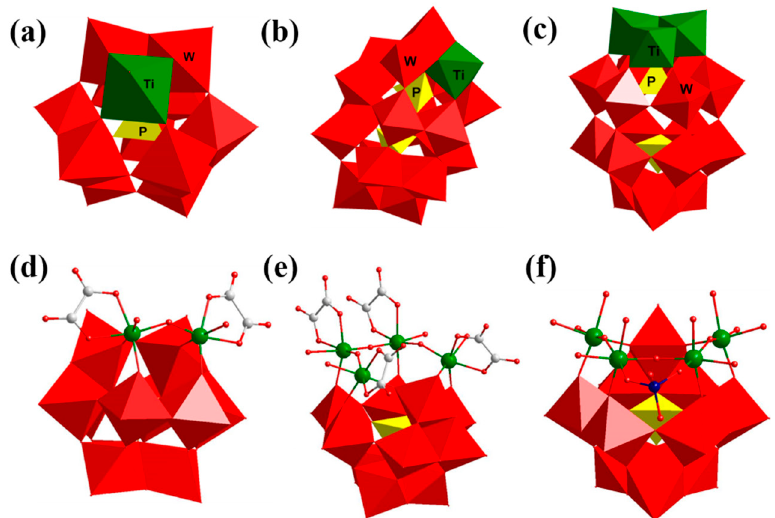
Figure 1. The ball-and-stick and polyhedral illustration of ( a ) [TiW 11 PO 40 ] 5 − polyoxoanion, ( b ) α 2 -[P 2 W 17 (TiO 2 )O 61 ] 8 − polyoxoanion, ( c ) [ α -1,2,3-P 2 W 15 (TiO 2 ) 3 O 56 (OH) 3 ] 9 − polyoxoanion, ( d ) [[{Ti(OH)(ox)} 2 ( µ -O)]( α -PW 11 O 39 )] 7 − polyoxoanion; ( e ) [[{Ti(ox)(H 2 O)} 4 ( µ -O) 3 ]( α -PW 10 O 37 )] 7 − poly- oxoanion, and ( f ) [[{Ti(H 2 O) 3 } 2 {Ti(H 2 O) 2 } 2 ( µ -O) 3 (SO 4 )](PW 10 O 37 )] − polyoxoanion. Color codes: WO 6 , red; PO 4 , yellow; Ti, green; S, dark blue; C, gray; O, red.